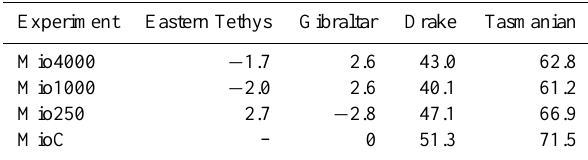
Table 2. Northward water transport (Sv) in the Tethys seaway, and eastward water transport (Sv) in Gibraltar, Drake and Tasmanian seaways for each of the four Miocene